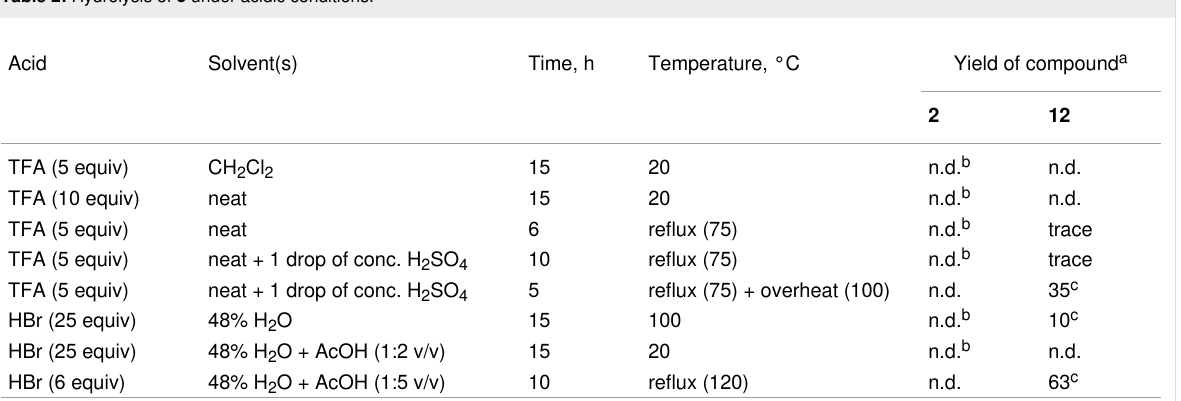
Table 2: Hydrolysis of 3 under acidic conditions.